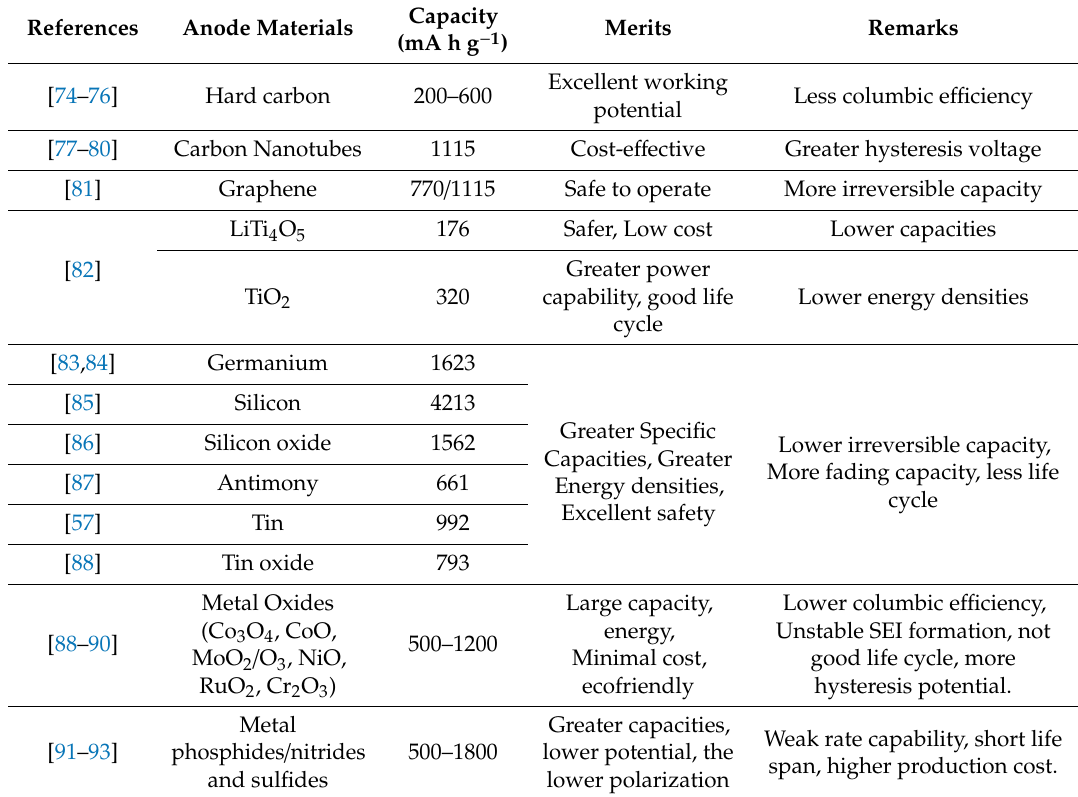
Table 1. Variety of Anode materials for Li-ion